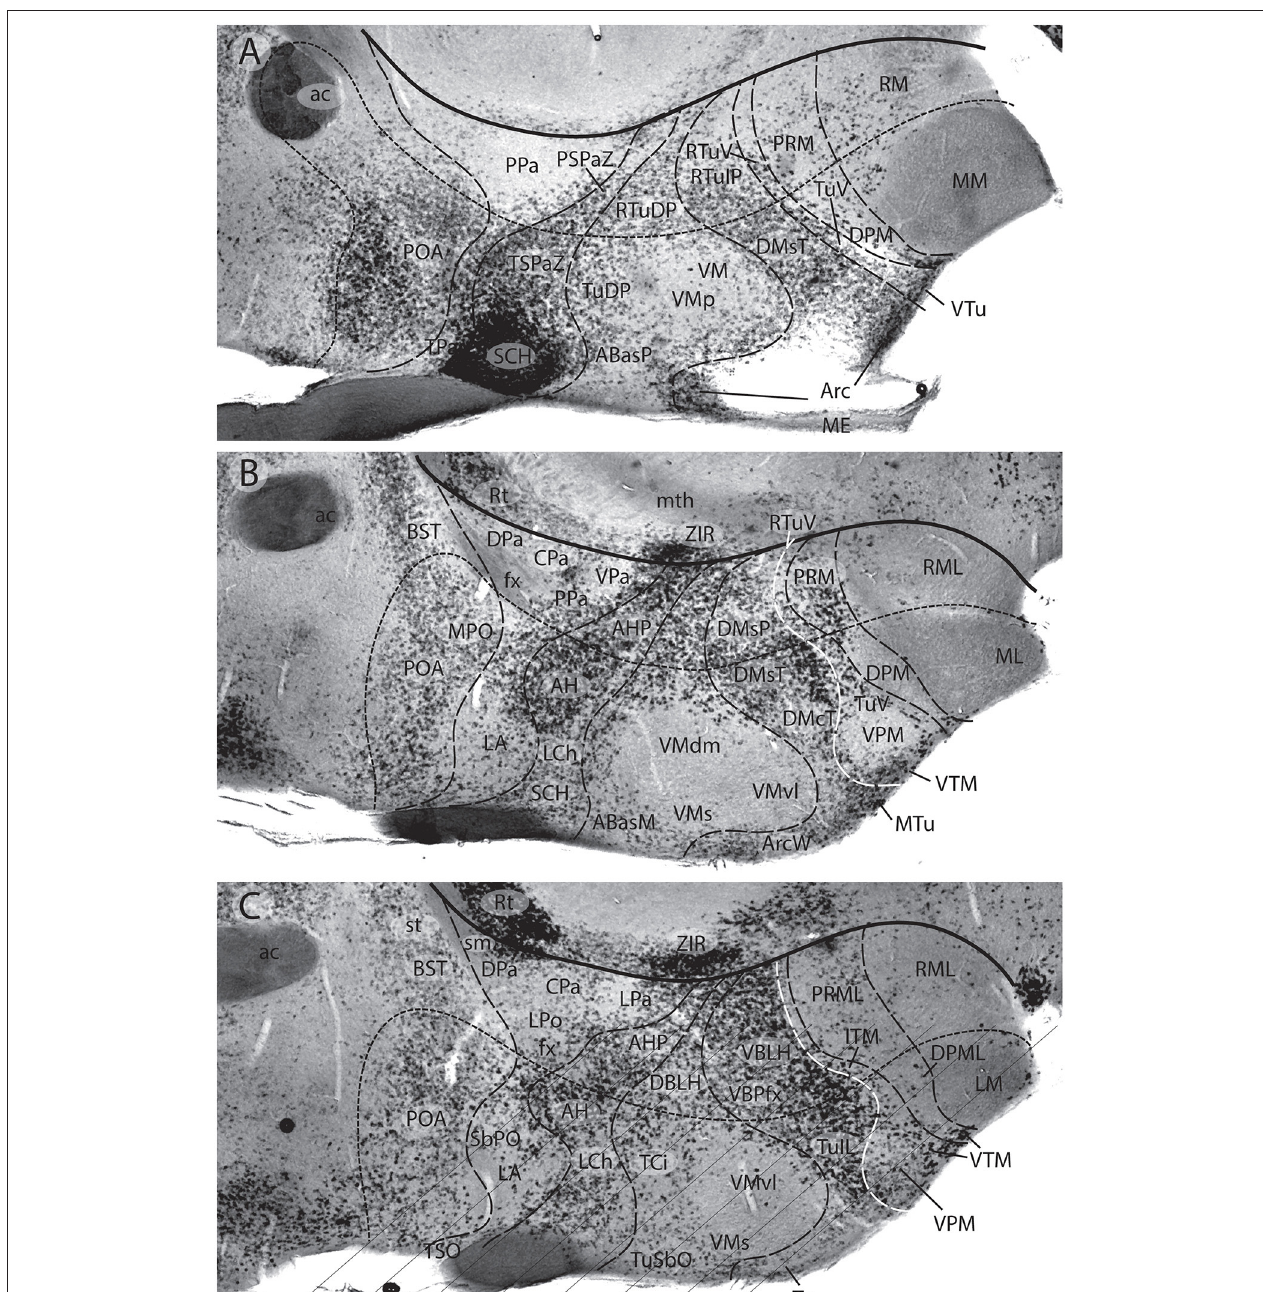
FIGURE 15 | Three sagittal sections adjacent to those in Figure 14 , through the adult mouse hypothalamus, shown in medio-lateral sequence (A–C) . They were in situ reacted for Gad67 , a gene marker of GABAergic inhibitory neurons (from Puelles L. et al., 2012a; no copyright permission required). The thick black line indicates the hypothalamo-diencephalic boundary (same overall orientation as Figure 14 ). The nearly parallel line with minute dashes is the intrahypothalamic segmental boundary separating PHy from THy (or hp1 from hp2). Orthogonal dash lines separate alar and basal longitudinal progenitor domains. The overall image readily shows that the hypothalamic formations with marked numbers of excitatory neurons ( Figure 14 ) have few if any GABAergic neurons (e.g., check LA, also most of the principal Pa nucleus, VM, VPM, DPM, MM, ML, LM; RM, RML— A–C ). The maximal presence of GABAergic neurons appears at the SCH nucleus, and less markedly at the neighboring AH and AHP, all of them subparaventricular derivatives. The full dorsomedial formation across both THy and PHy is also rich in GABAergic neurons. The prethalamus (e.g., Rt; ZIR) also emerges as a GABAergic territory (B,C) . There is also a shell of GABA cells around the VM nucleus (A–C) . The preoptic area (POA) is also well provided with GABAergic neurons (A–C) . Seeing the curved and topographically oblique (deformed) boundary lines that separate paraventricular from subparaventricular alar entities, as well as basal formations, one understands that the habitual atlas coronal sections are not helpful in understanding these alternative distributions highlighted by the selective molecular markers and more appropriate sagittal section